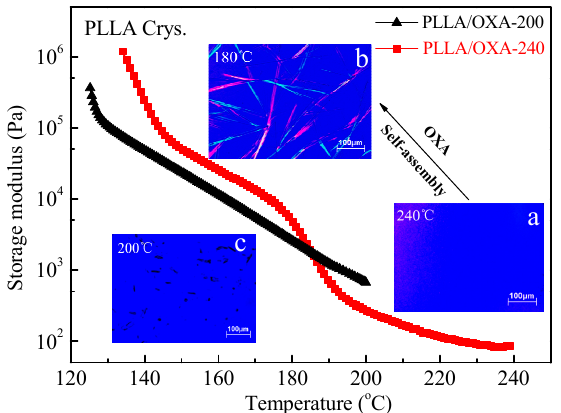
Figure 4. Storage modulus versus temperature for the PLLA/OXA samples upon cooling from 200 and 240 °C, respectively. Three POM images performed under static conditions are shown: ( a ) PLLA/OXA-240 at 240°C; ( b ) PLLA/OXA-240 at 180°C; and ( c ) PLLA/OXA-200 at 200°C.